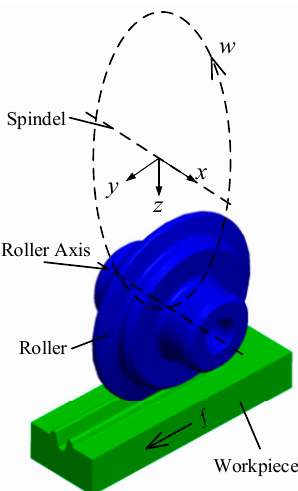
Figure 1. Schematic of the cold roll-beating (CRB) principle of an external tooth groove.